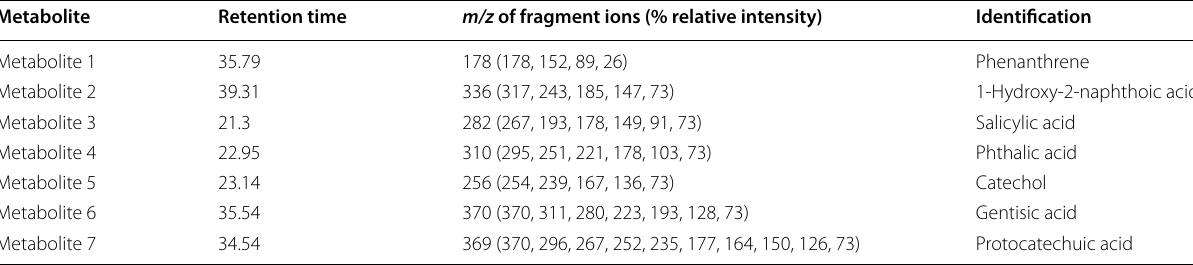
Table 2 Metabolites detected in phenanthrene degradation by consortium CY-1